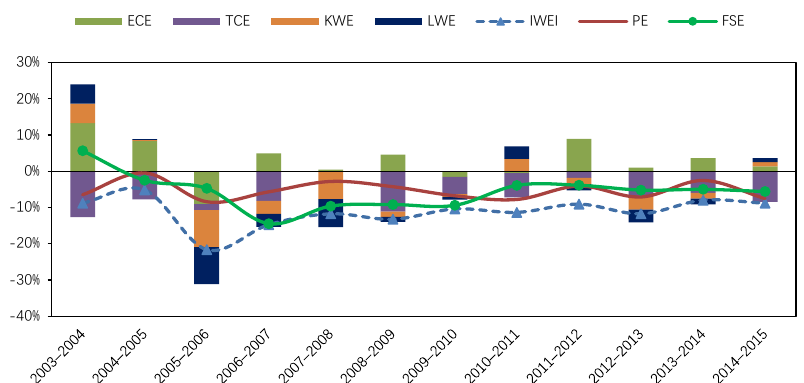
Figure A1. Driving factors of industrial wastewater emission intensity change in the Northeast Area, 2003 – 2015. ECE: the effect of technical efficiency change; TCE: the effect of technological change; KWE: the effect of capital – wastewater substitution; LWE: the effect of labor – wastewater substitution; IWEI: industrial wastewater emission intensity; PE: productivity effect; FSE: factor substitution effect.